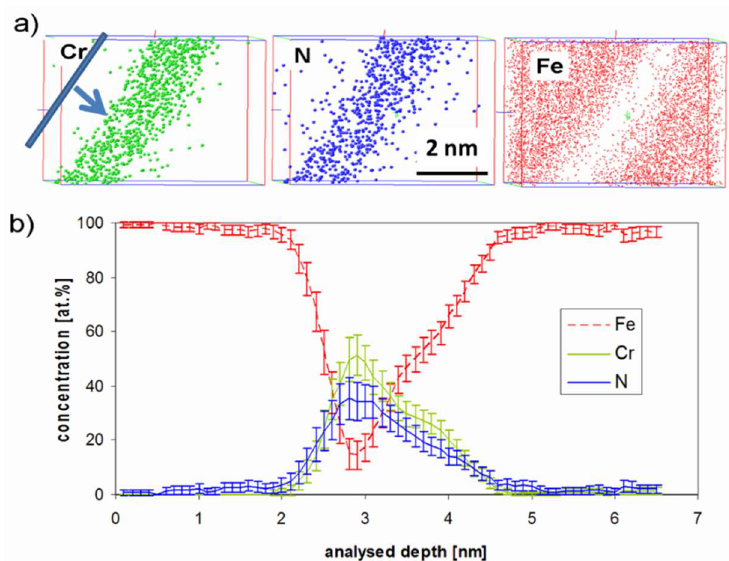
Figure 6. ( a ) Elemental atom maps around a selected nitride and ( b ) corresponding composition profile obtained perpendicular to the nitride habit plane, with a resolution of 0.1 nm. The sampling volume (0.1 nm thick) and profile direction are indicated on the top left of the Figure 6a.